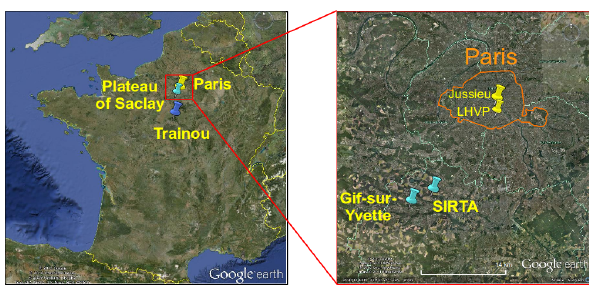
Fig. 1. Location of the different sampling